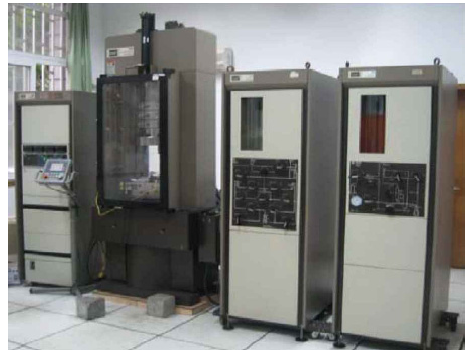
Figure 4. MTS 815 Rock Material